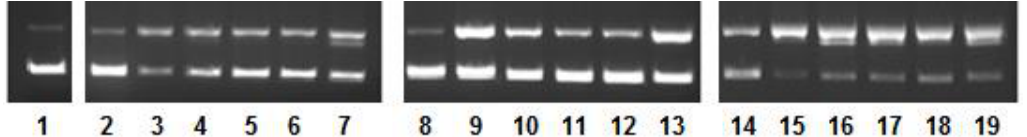
Figure 6. Electrophoretic pattern of pBR322DNA in the presence of scavengers/groove binders in 50